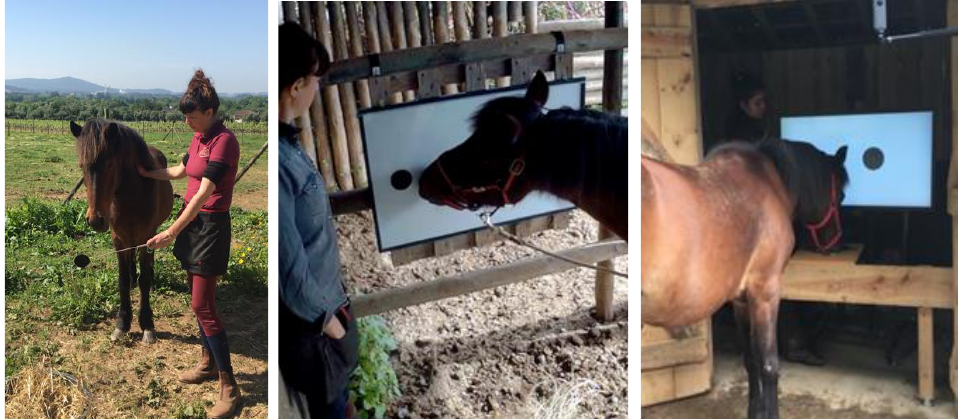
Figure 3. Targeting training with the horse Boneko. ( Left ): Presentation of a black circle target on a telescopic probe in the field. ( Center ): Presentation of the black circle target on a magnetic board. ( Right ): Targeting training performed on the computer-controlled touchscreen with the black circle target. During the preliminary training, the horses gradually habituated to individual testing, away from the rest of the OMU. Without the lead rope connected to the halter, the horse was free to approach the apparatus ( Photos by Barbara Ryckewaert).